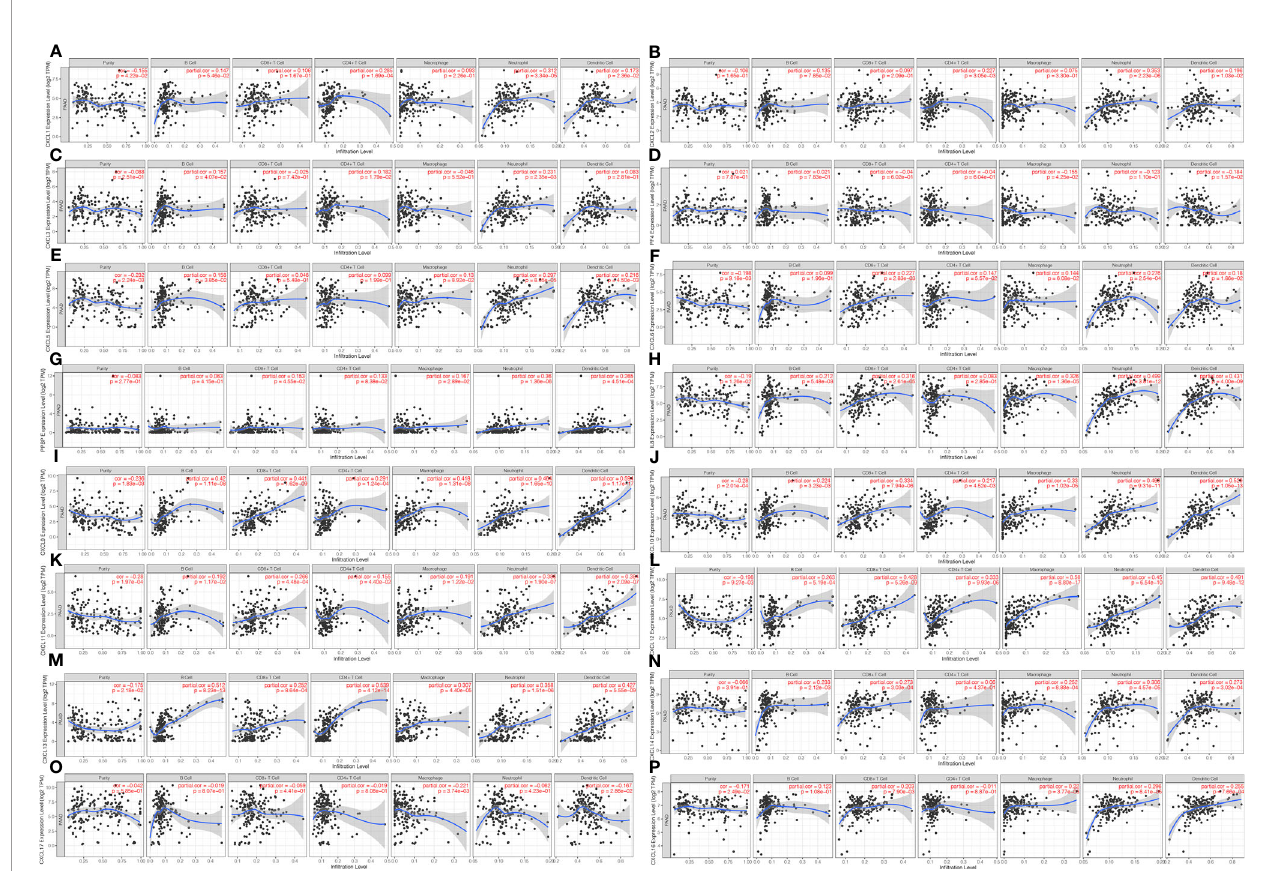
FIGURE 6 | The correlation between CXC chemokines and immune cell in fi ltration (B cells, CD4+ T cells, CD8+ T cells, neutrophils, macrophages, and dendritic cells) in PAAD (TIMER). (A) CXCL1 (B) CXCL2 (C) CXCL3 (D) CXCL4 (E) CXCL5 (F) CXCL6 (G) CXCL7 (H) CXCL8 (I) CXCL9 (J) CXCL10 (K) CXCL11 (L) CXCL12 (M) CXCL13 (N) CXCL14 (P) CXCL16 (O)